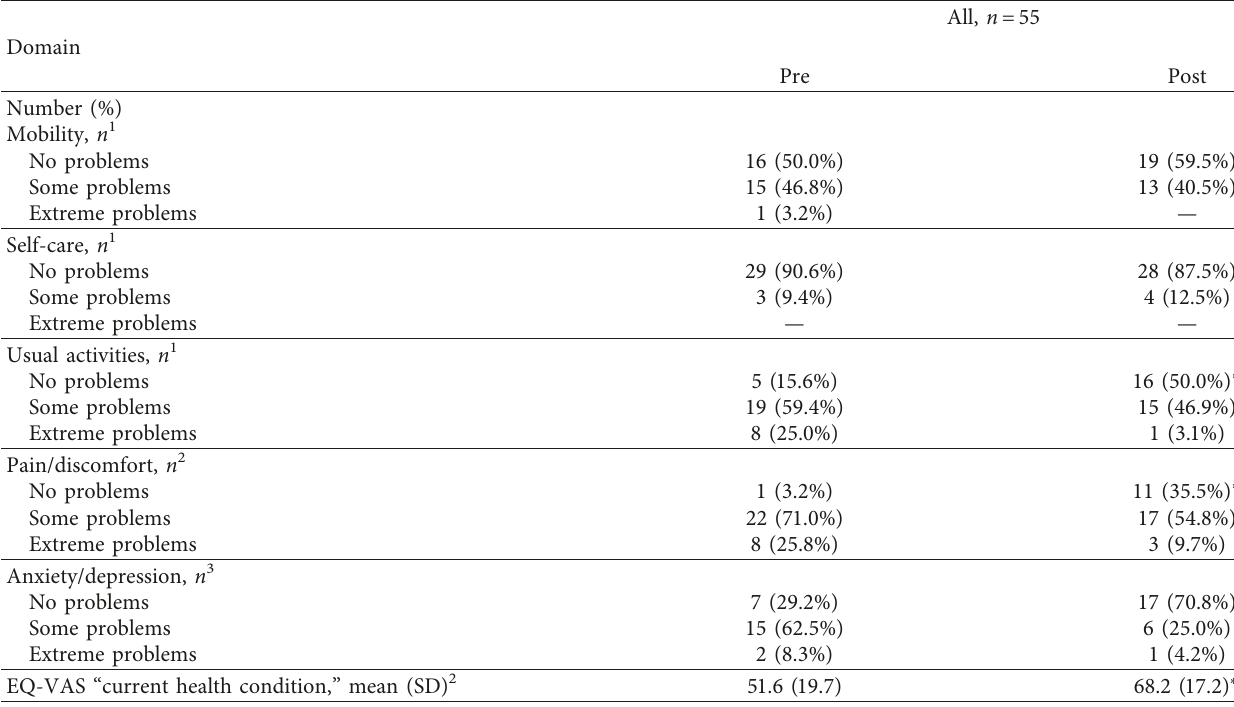
Table 4: EQ-5D scores per domain and EQ-VAS